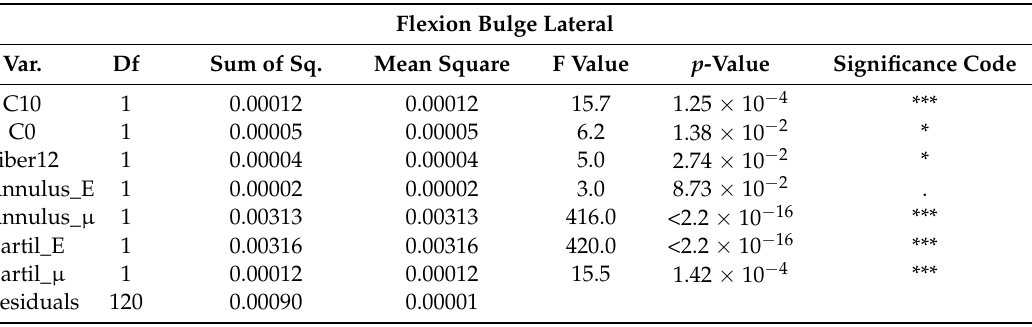
Table 22. ANOVA table for a flexion bulge lateral linear